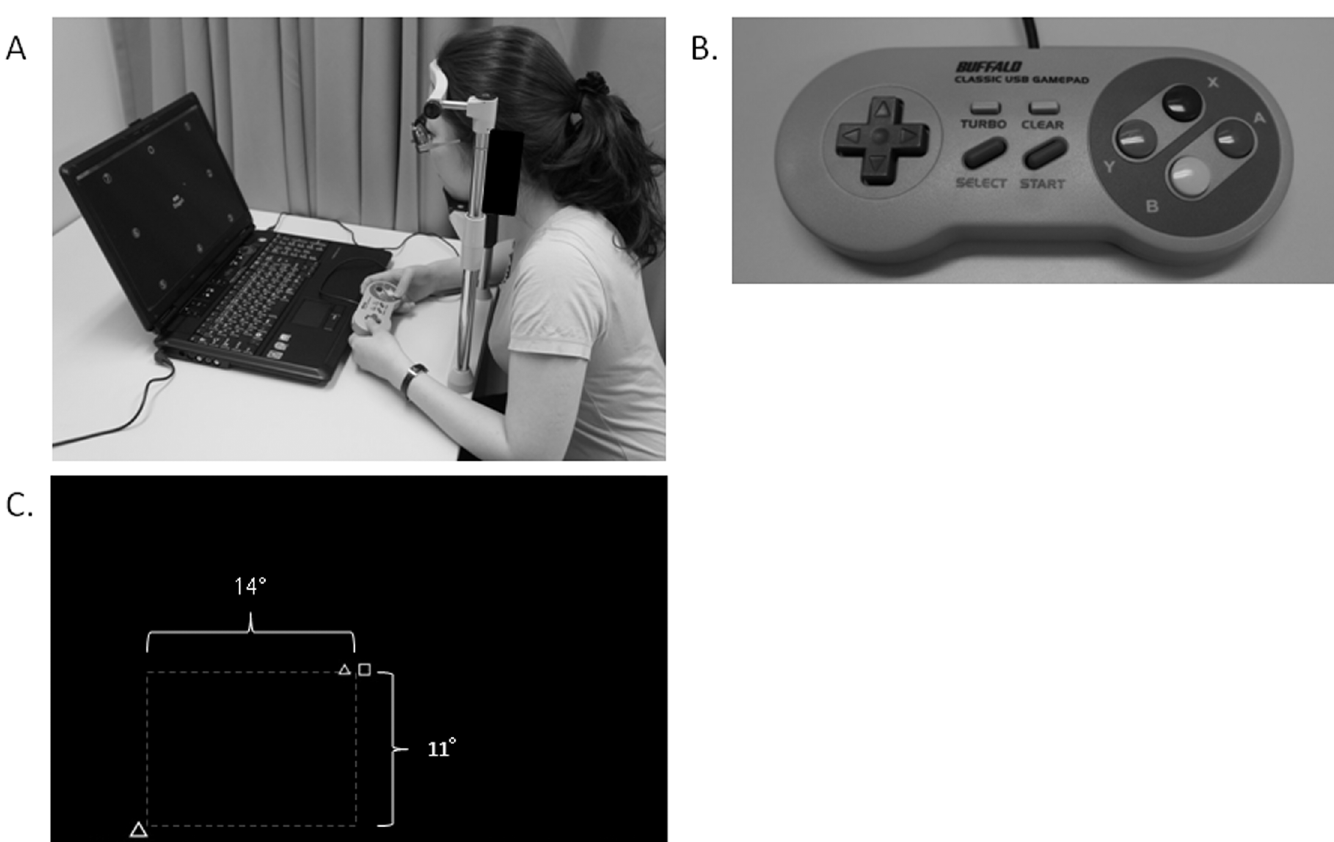
Fig 2. Useful field of view with the VFIT-EV test. (A) Useful field of view with the VFIT-EV test. (B) Game controller used to respond during the VFIT-EV test. (C) Screen display of the VFIT-EV, dual-task test (actual test).